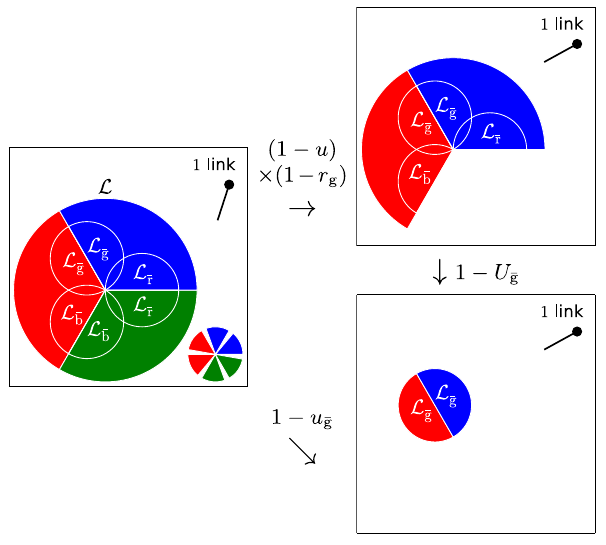
FIG. 10. Calculation of U ¯ assumed independence of the qualities of the link under consid- eration, especially of the color it connects to and if it connects to the giant